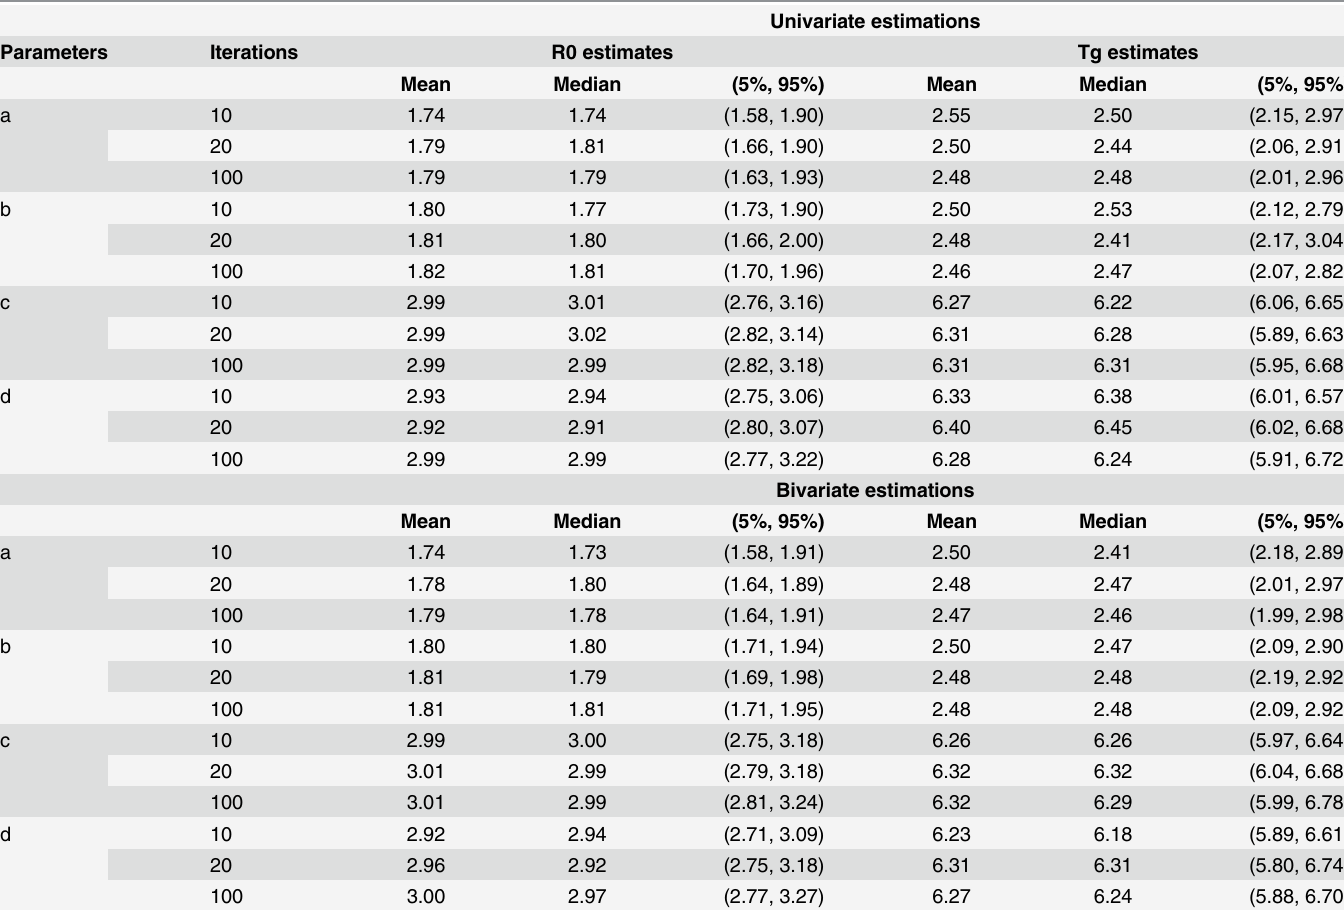
Table 1. Univariate and bivariate estimates of the model using Poisson distributed serial interval, different k values, and number of simulation iter- ations. The following parameters were used: (a) R 0 = 1.8, T g = 2.5, k = 10; (b) R 0 = 1.8, T g = 2.5, k = 25; (c) R 0 = 3.0, T g = 6.25, k = 10; (d) R 0 = 3.0, T g = 6.25, k = 25. PI: prediction